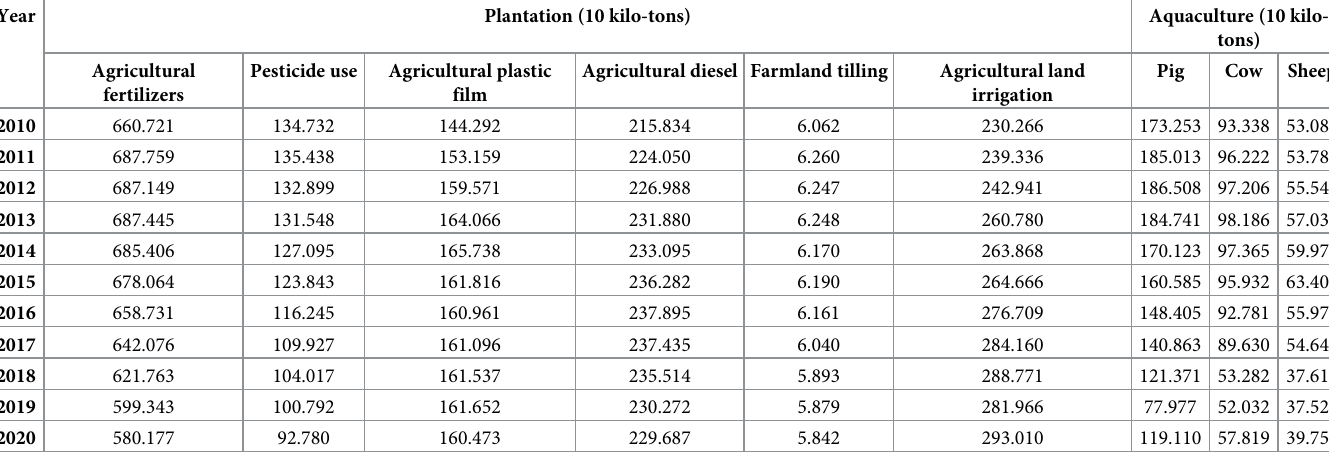
Table 5. Carbon emissions from agriculture in the YRD, from 2010 to